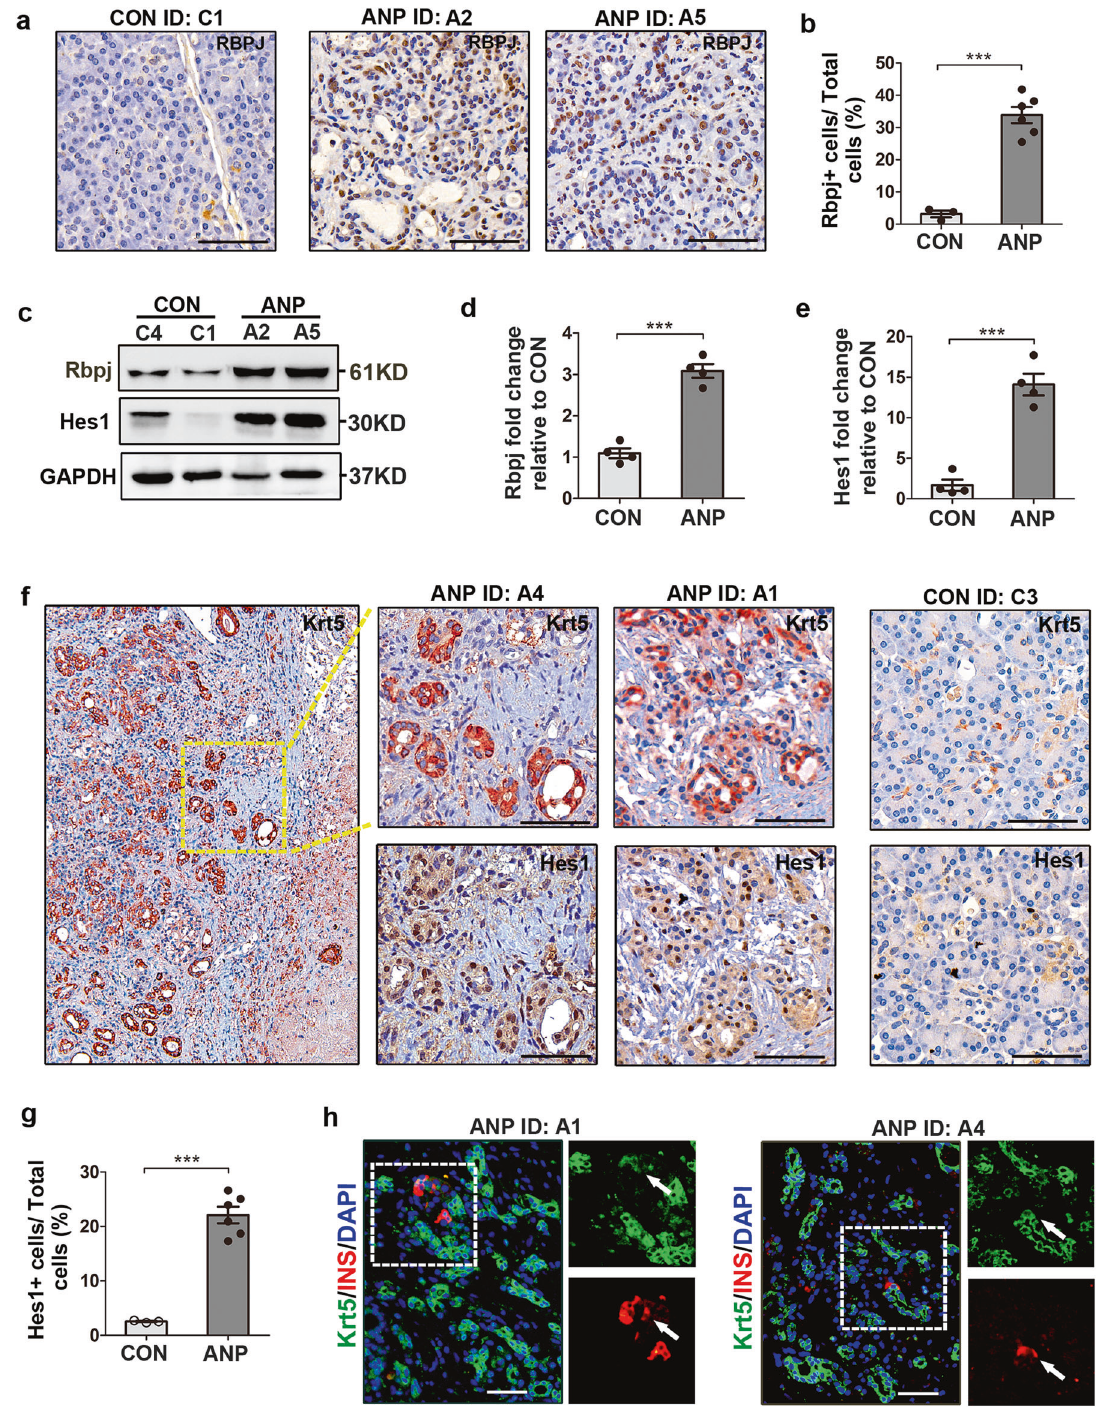
Fig. 3 Persistent Notch activity in ANP pancreases correlates with Krt5 + colonies and duct-like structures. a , b Representative staining and quanti fi cation of Rbpj expression in pancreases of control and ANP individuals. c Representative western blots of Rbpj and Hes1 in pancreases from control individuals and ANP patients. d , e Quanti fi cation of western bolts for Rbpj ( d ) and Hes1 ( e ) in ANP pancreases compared with that in control pancreases. f Representative images of serial sections stained with Krt5 and Hes1 showing that Krt5 + duct-like or clustered structures were also immunopositive to nuclear Hes1. g Quanti fi cation of Hes1 + cells divided by total cells (shown as %), plotted as fold change vs control. h Images of pancreases from ANP individuals immunostained with Krt5 (green), insulin (red) and DAPI (blue) showing seldomly noticed double-labeling cells (white arrowhead). ANP, acute necrotic pancreatitis; CON, control. Data are mean ± SEM, n = 3 – 6. *** p < 0.001. Scale bars, 50 μ m.